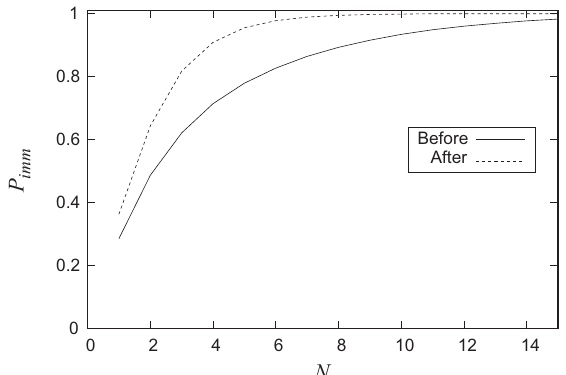
Figure 13. Dependence of the probability P imm on the number N